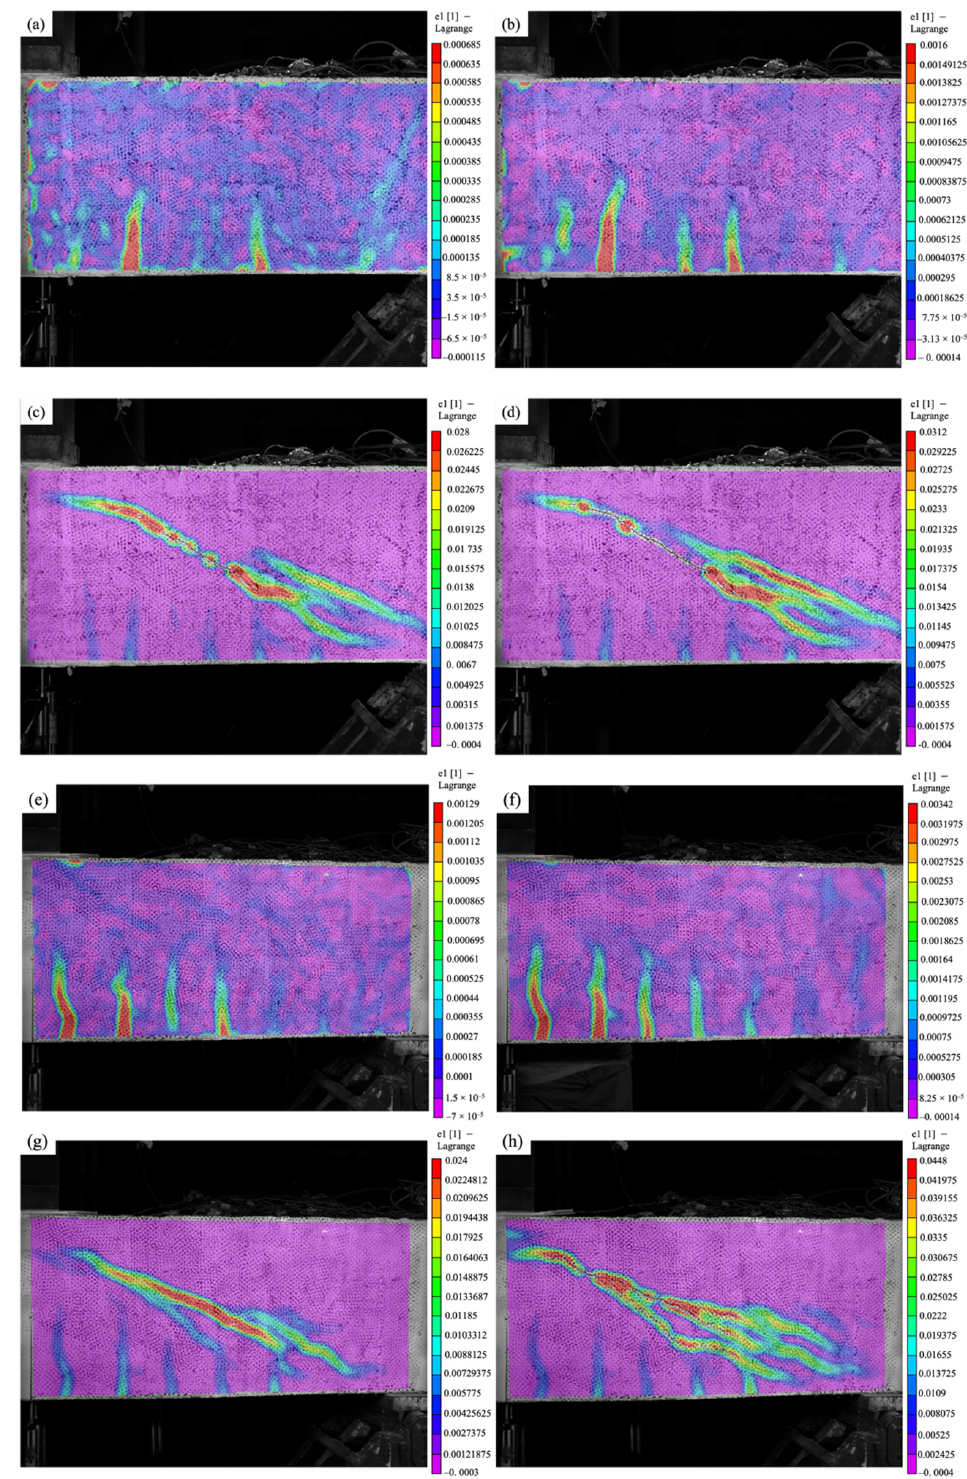
Figure 10. Load–strain relation of concrete for: ( a ) specimen 20 × 30 @ 200 at 0.25 P u ; ( b ) specimen 20 × 30 @ 200 at 0.5 P u ; ( c ) specimen 20 × 30 @ 200 at 0.75 P u ; ( d ) specimen 20 × 30 @ 200 at P u ; ( e ) specimen 20 × 30 @ 100 at 0.25 P u ; ( f ) specimen 20 × 30 @ 100 at 0.5 P u ; ( g ) specimen 20 × 30 @ 100 at 0.75 P u ; and ( h ) specimen 20 × 30 @ 100 at P u.